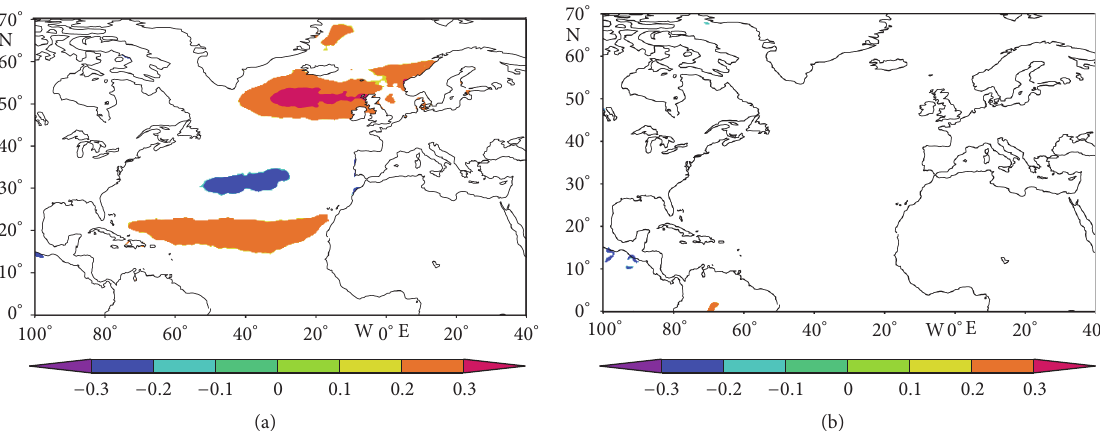
Figure 6: Correlation between wind power density and NAO. (a) Contemporaneous correlation; (b) correlation between the NAO index and wind power density (lagging 2 months). Only areas significant at the 95% level are shown.